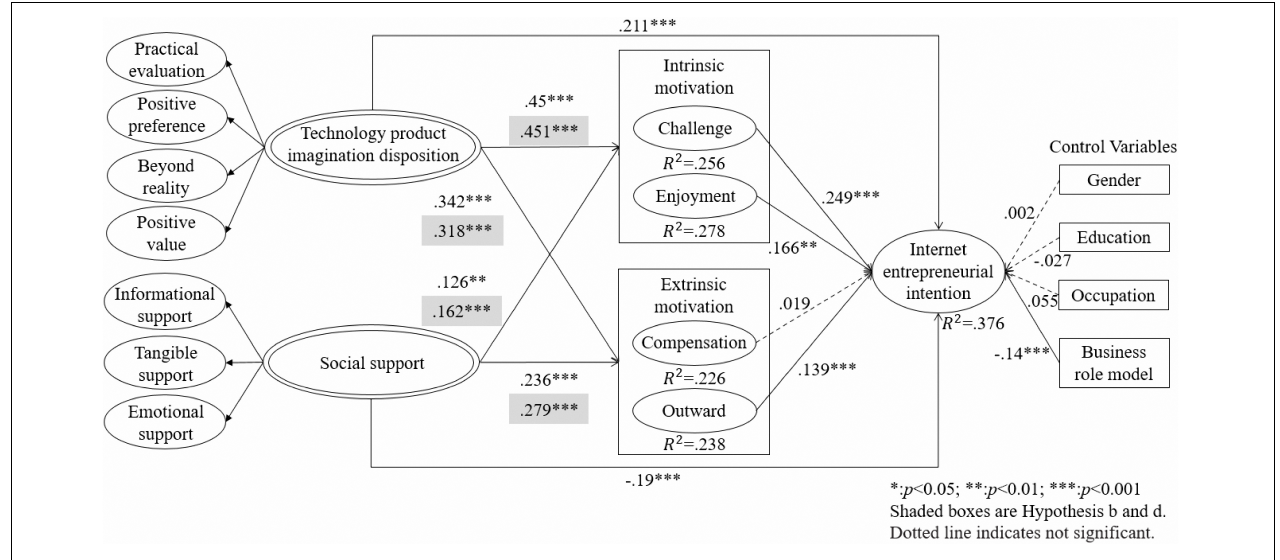
FIGURE 2 | Results of partial least squares